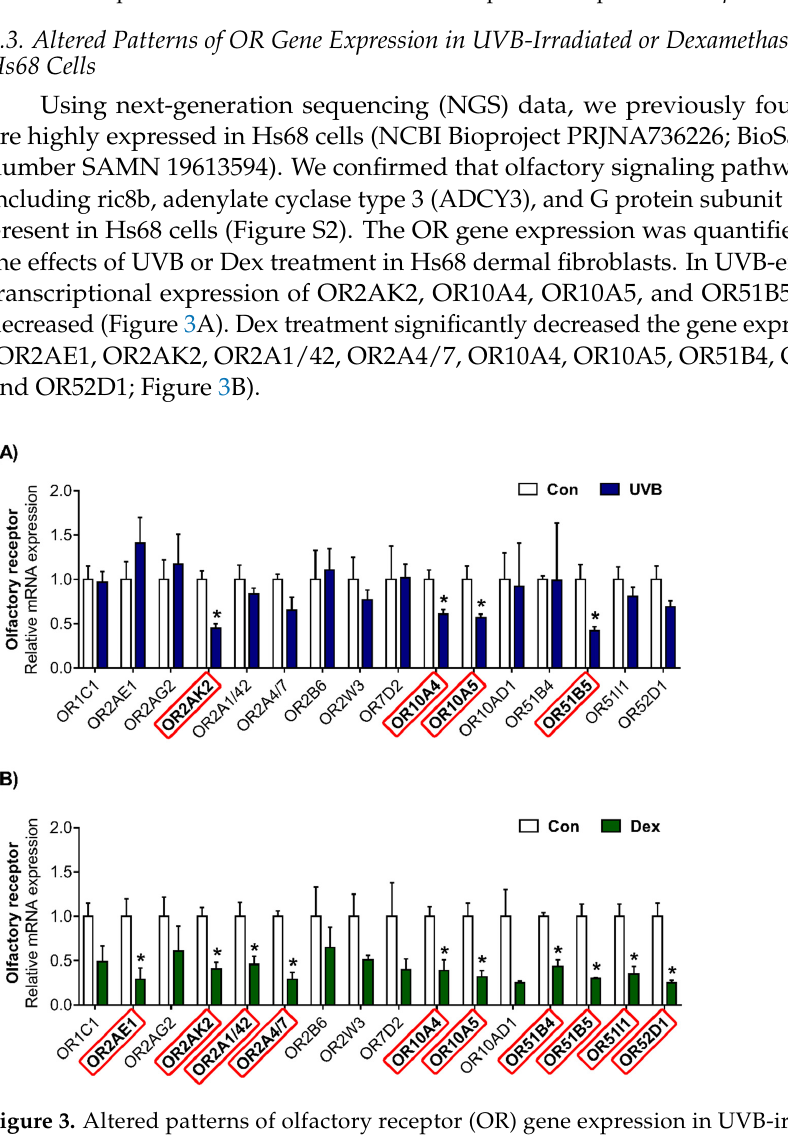
Figure 3. Altered patterns of olfactory receptor (OR) gene expression in UVB ‐ irradiated or Dex ‐ induced Hs68 cells. The cells were treated with or without ( A ) 20 mJ/cm 2 UVB or ( B ) 1 μ M Dex. After treatment for 12 h, the relative mRNA expression of 16 ORs ( OR1C1 , OR2AE1 , OR2AG2 , OR2AK2 , OR2A1/42 , OR2A4/7 , OR2B6 , OR2W3 , OR7D2 , OR10A4 , OR10A5 , OR10AD1 , OR51B4 , OR51B5 , OR51I1 , and OR52D1 ) were analyzed. GAPDH was used as the reference gene for PCR. Red rectangle represents differentially expressed genes between each treatment and control group (Con). The results are expressed as mean ± SEM of three independent experiments. * p < 0.05. 2.4. OR51B5 Knockdown Decreased Hs68 Cell Viability We hypothesized that some of the 10 altered OR genes may play a role in regulating cell survival in Hs68 cells. To test this, we decided to use siRNA screening approach and measured the viability of the Hs68 cells transfected with non ‐ targeting small interfering RNA (siRNA; NT) or two distinct siRNAs (#1 and #2) against 10 ORs ( OR2AE1 , OR2AK2 , OR2A1/42 , OR2A4/7 , OR10A4 , OR10A5 , OR51B4 , OR51B5 , OR51I1 , and OR52D1 ). Viability was significantly decreased only in OR51B5 siRNA ‐ transfected cells compared with NT ‐ transfected cells (Figure 4A). To confirm the knockdown efficiency and select the more effective siRNA between the two siRNAs (siRNA #1 and siRNA #2) targeting different regions in the OR51B5 mRNA, we measured the OR51B5 expression in Hs68 cells transfected with NT or OR51B5 siRNA #1 and #2. The OR51B5 expression was decreased by 77.1 and 81.4% in OR51B5 siRNA #1 ‐ or #2 ‐ transfected Hs68 cells, respectively (Figure 4B). Hence, OR51B5 siRNA #2 was used to knockdown the OR51B5 expression in the subsequent experiments. We further confirmed that the LDH was significantly elevated in OR51B5 siRNA ‐ transfected cells compared with NT ‐ transfected cells, suggesting that reduced cell viability by OR51B5 knockdown is related to cell death (Figure 4C).